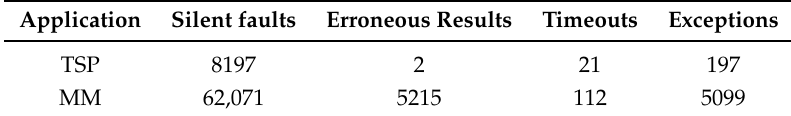
Table 1. Results of the fault-injection campaigns on applications running on the MPPA-256.